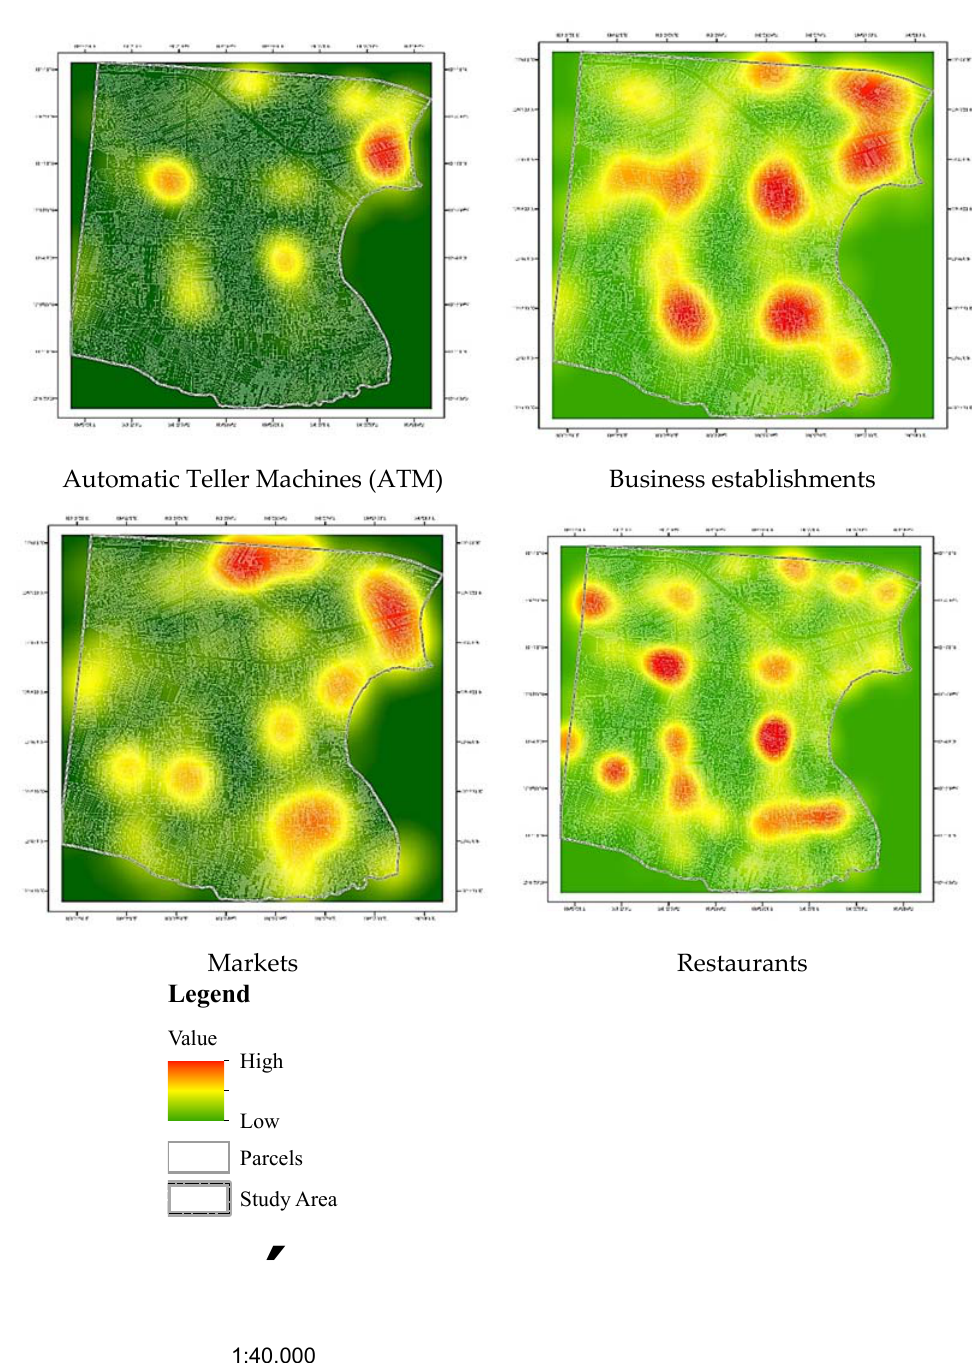
Figure 3. Kernel density estimation of independent variables.